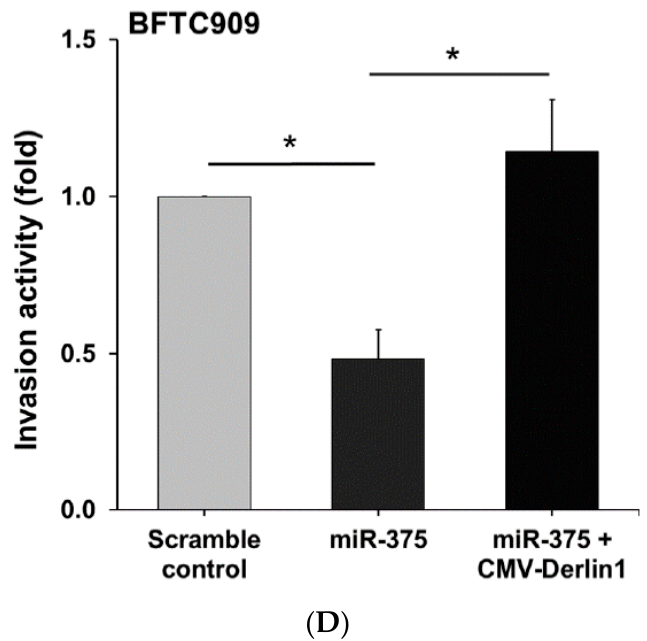
Figure 5. MiR-375-3p negatively regulates Derlin-1 and blocks EMT in BFTC909 cells. ( A ) Western blot revealed the restoration of Derlin-1, MMP-2, Snail, and ZEB1 after co-transfection of miR-375-3p mimics and CMV-Derlin-1 compared with cells transfected with miR-375-3p alone in BFTC909 cells with α -tubulin as a reference ( B ) Quantification of the protein levels of Derlin-1, occludin, MMP-2, Snail, and ZEB1 from ( A ) (N = 3). ( C ) miR-375-3p suppressed BFTC909 cell migration ability but restored by Derlin-1 overexpression (N = 3). ( D ) miR-375-3p repressed invasion of BFTC909 cells but restored by Derlin-1 overexpression (N = 3). Data were represented as mean ± SD; * p < 0.05, ** p < 0.01.